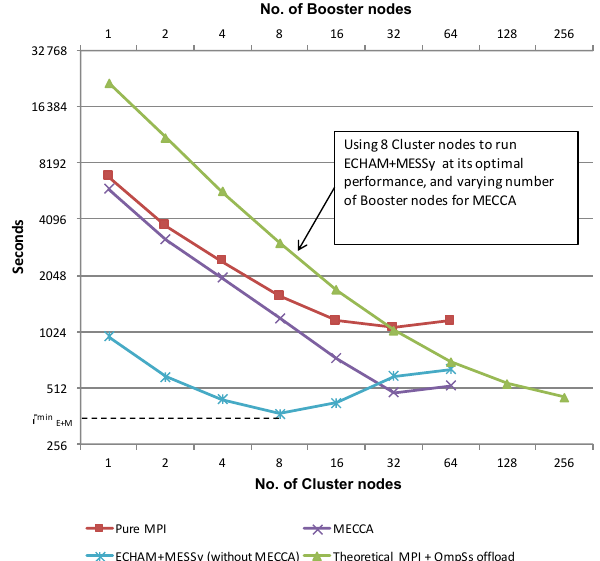
Figure 8. Time per simulated day in DEEP using a pure MPI ap- proach, and a theoretical performance with offloading to Xeon Phi, based on the metrics collected on MareNostrum 3. The theoretical MPI + OmpSs offload data are based on a fixed configuration on the Cluster using eight nodes and scaling the number of Booster nodes.